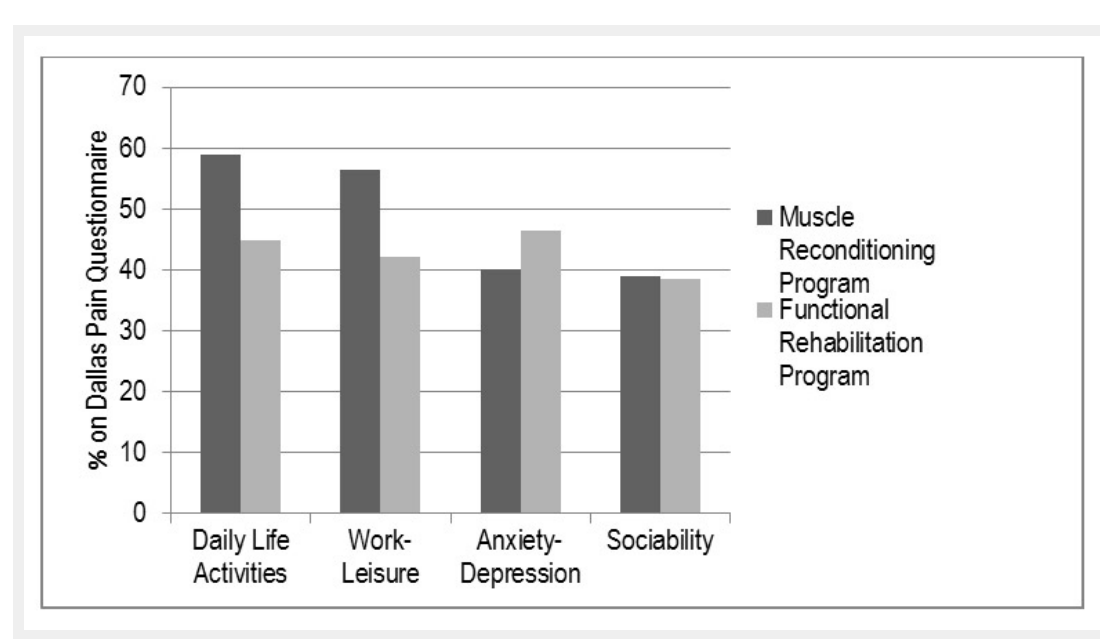
Figure 1 Results at follow-up for the two programmes for each of the Dallas Pain Questionnaire subscales. A difference was observed favouring the multidisciplinary functional rehabilitation programme in terms of “daily life activities” and “work-leisure” with a trend toward statistical